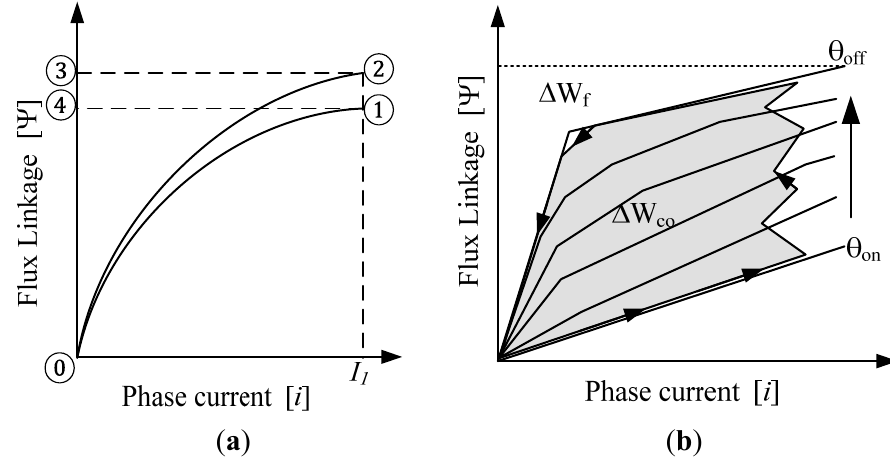
Figure 2. Energy conversion principles: ( a ) Ideal condition; ( b ) Practical